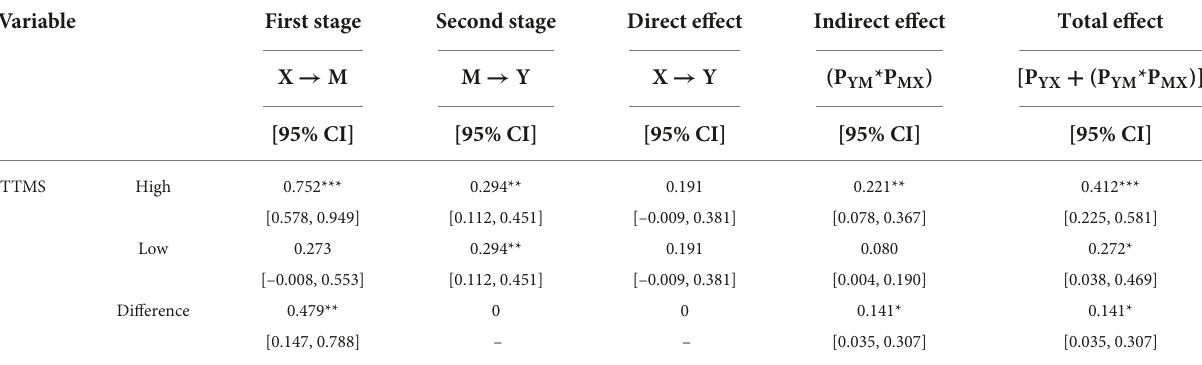
TABLE 3 Analysis results of moderated mediating effect (TMS).